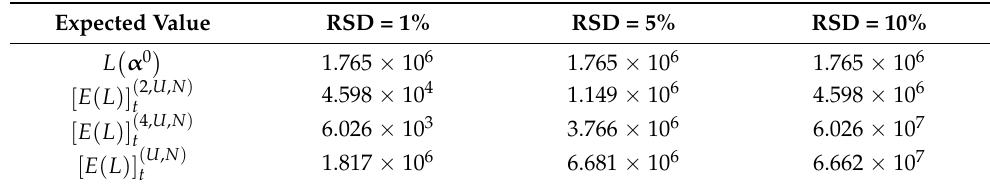
Table 3. Comparison of expected values for various relative standard deviations (RSD) of the normally distributed and uncorrelated microscopic total cross